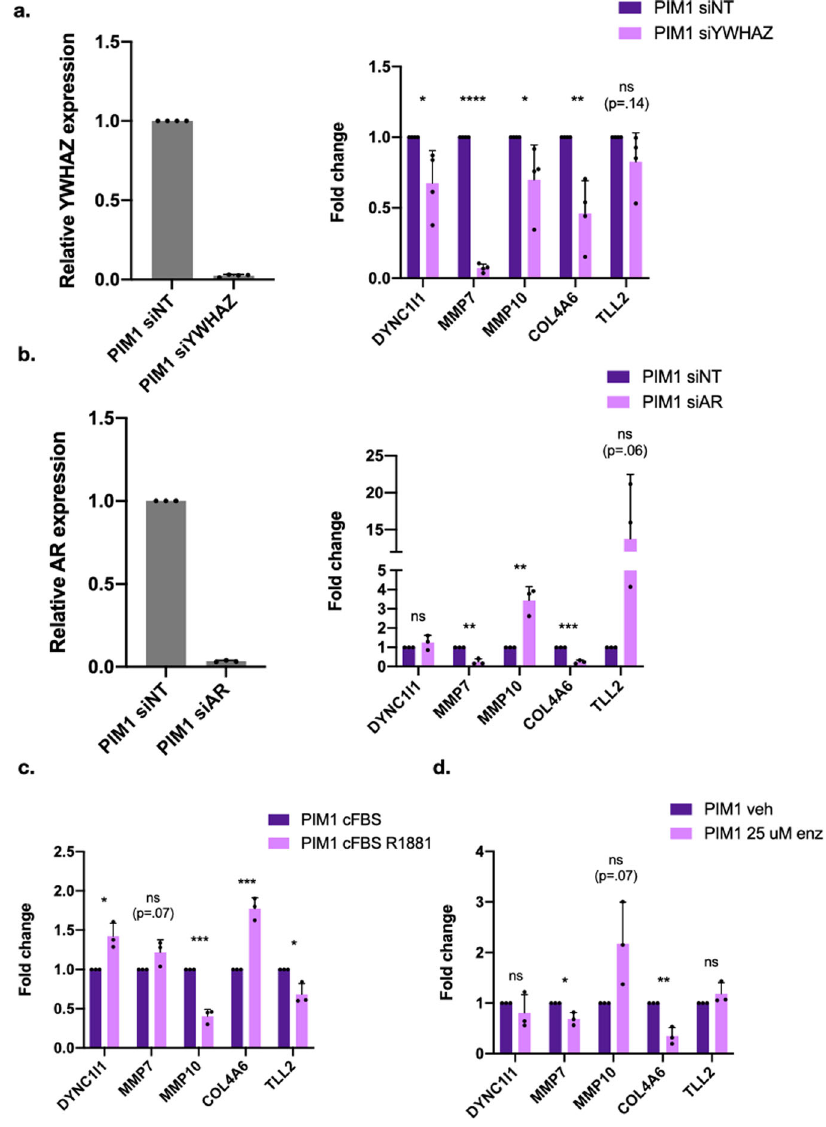
Fig. 5 Expression of PIM1 upregulated genes are dependent on 14-3-3 ζ and AR expression and activity. a Knockdown of 14-3-3 ζ results in decrease in expression of PIM1-induced genes involved in cell migration and invasion (DYNC1I1: 0.68 + / − 0.23, p = 0.030. MMP7:0 .072 + / − 0.038, p <0.0001. MMP10: 0.70 + / − 0.25, p = 0.025. COL4A6: 0.46 + / − 0.23, p = 0.0034. TLL2: 0.83 + / − 0.21, p = 0.14. n = 4 biological replicates, two sided T test).